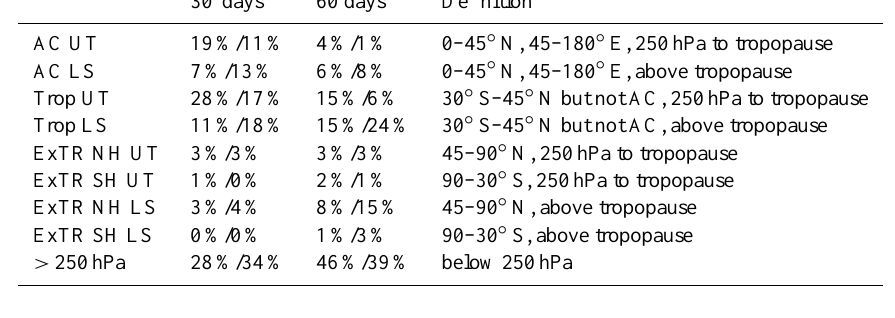
Table 1. Fraction of trajectories located in different regions of the atmosphere after 30 and 60 days for kinematic/diabatic transport.